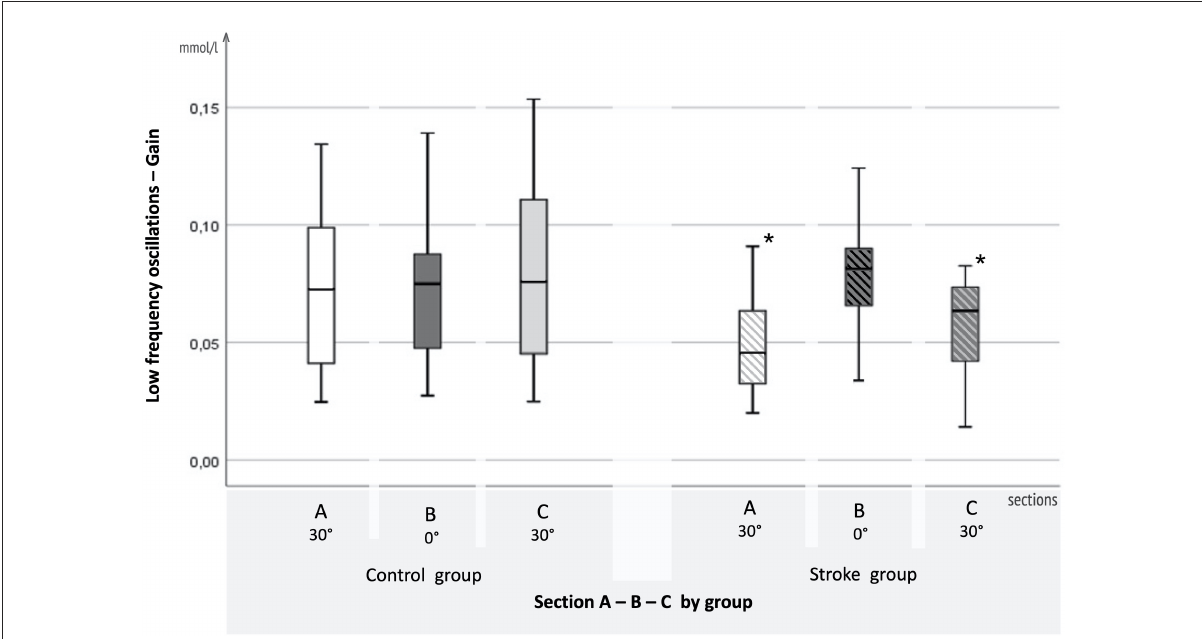
FIGURE4 Results for LFO. Boxplots of adjusted gain in the low-frequency oscillation range for the AIS and control groups. On the x -axis, 3-, 5-min sections A (30 ◦ ), B (0 ◦ ), and C (30 ◦ ), are displayed for the control group on the left and the AIS group on the right. Gain in mmol/l is plotted on the y-axis.